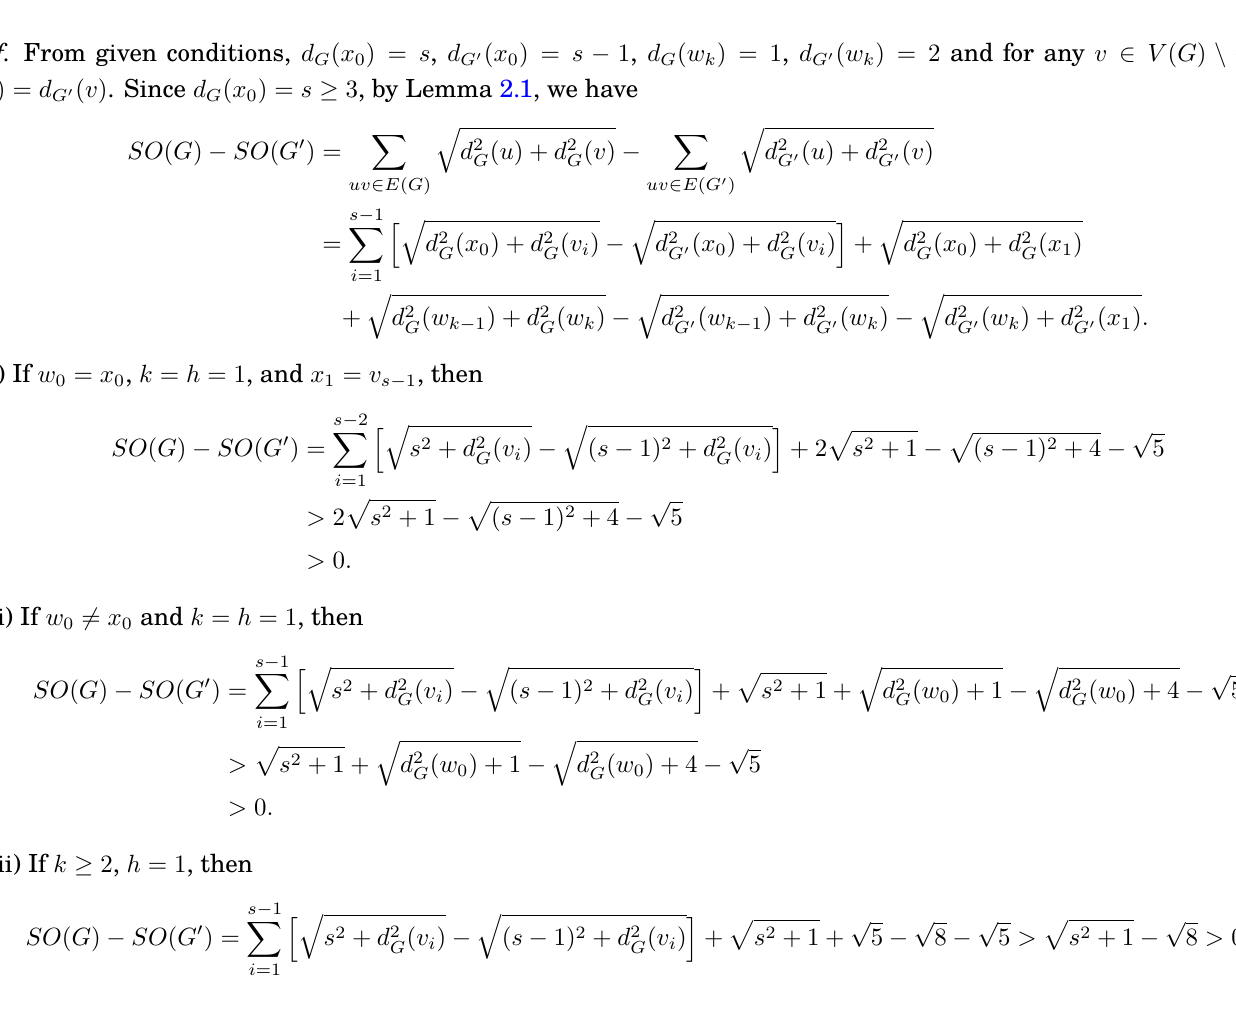
Figure 2: An illustration of Lemma